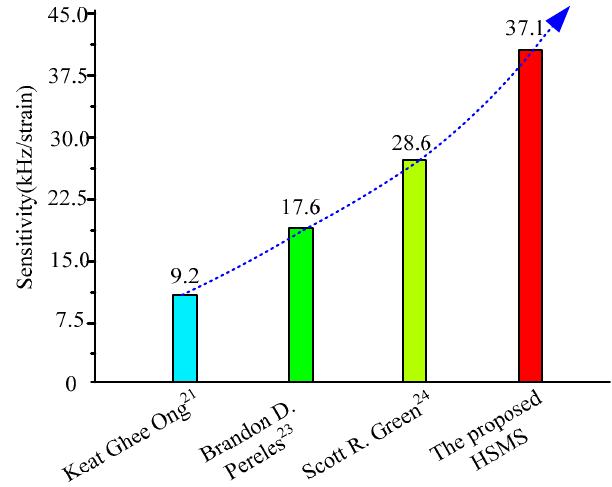
Figure 11. Frequency sensitivity comparison between the proposed HSMS and several other works.